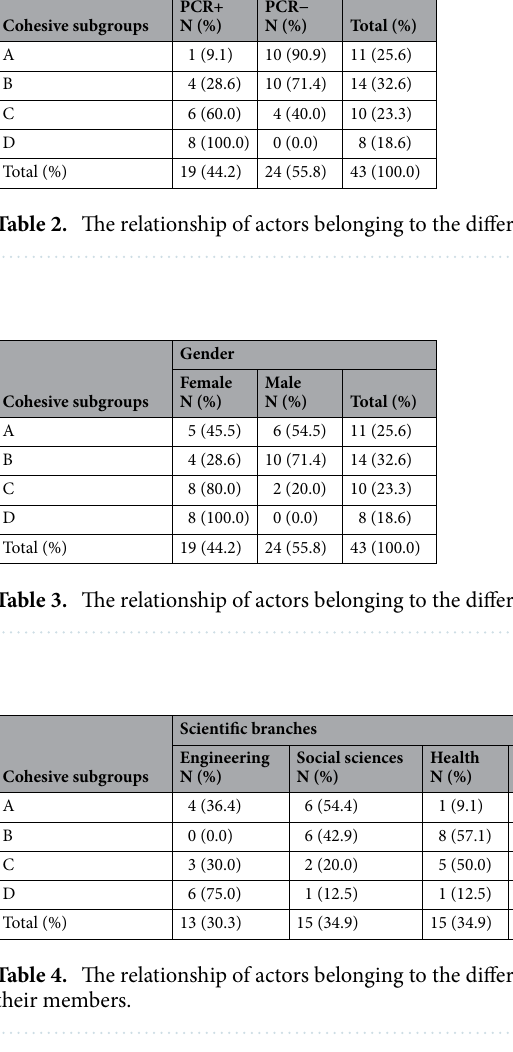
Cohesive subgroups